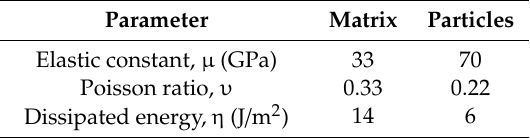
Table 1. Elastic constants for Al and Si and the energy dissipated upon crack formation. Parameter